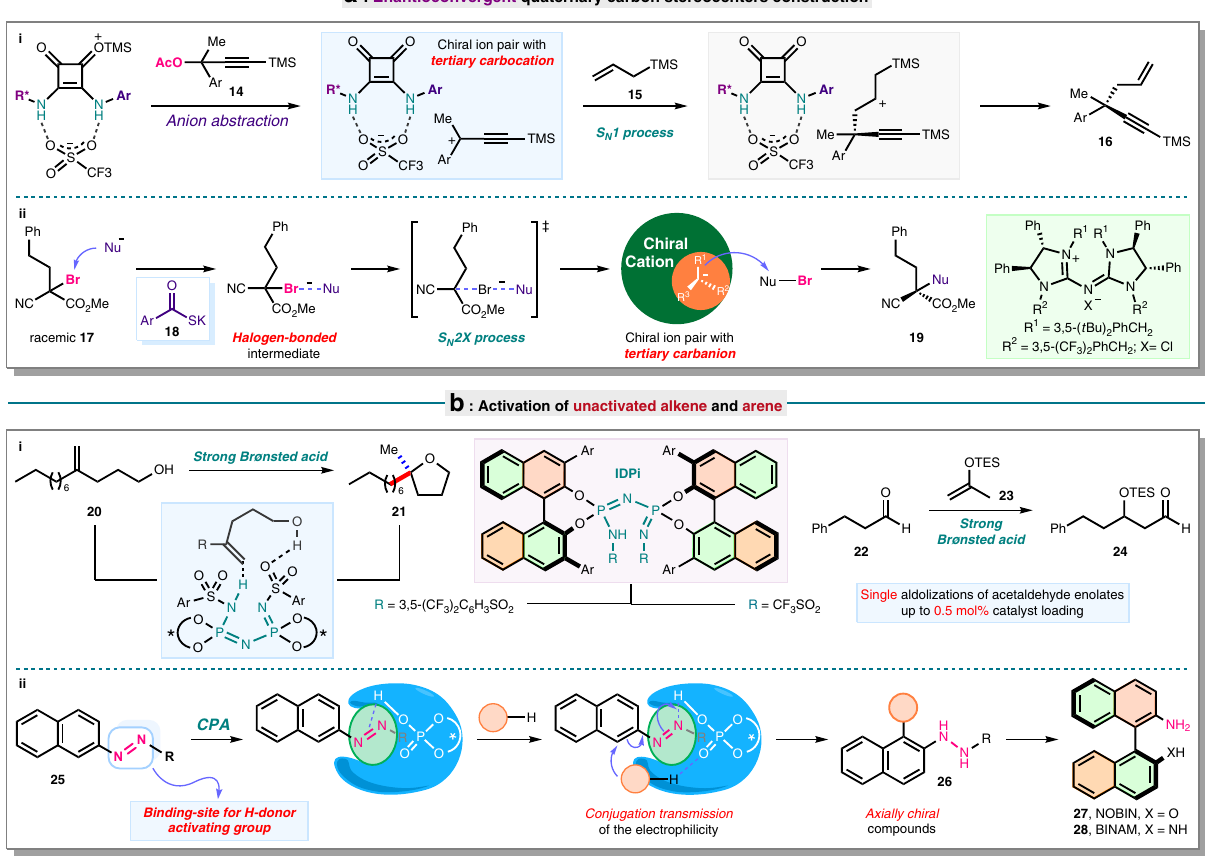
Fig. 2 Important target-oriented developments. a Chiral ion pair enabled quaternary carbon stereocenters construction in enantioconvergent manner. b Application in inactive alkene and arene